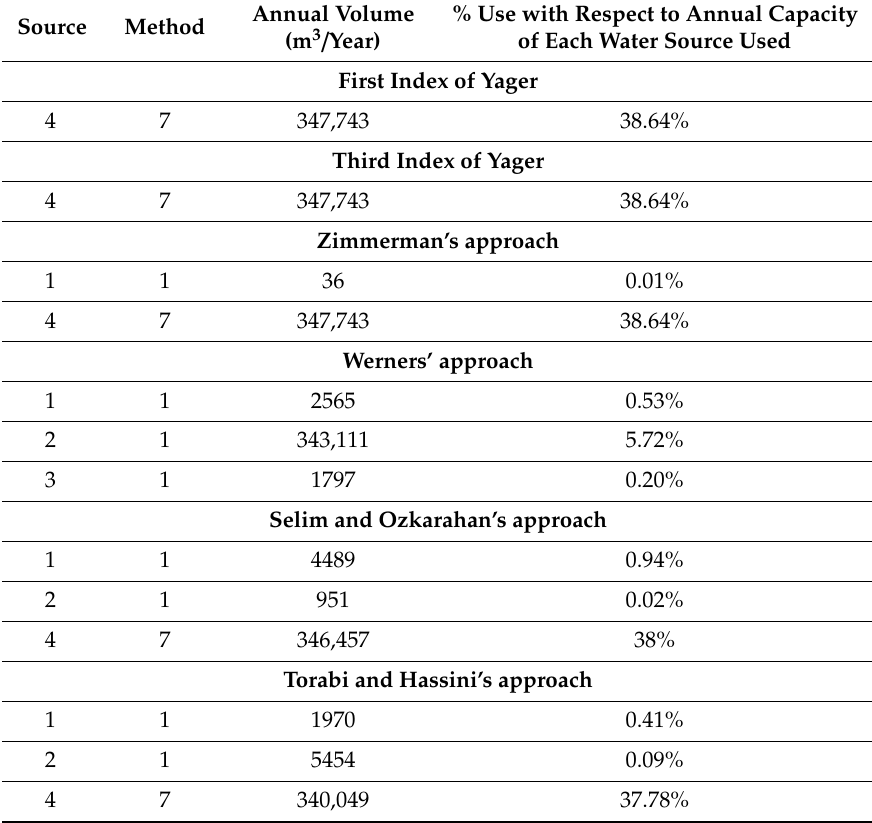
Table 7. Comparison of annual volume and percentage of